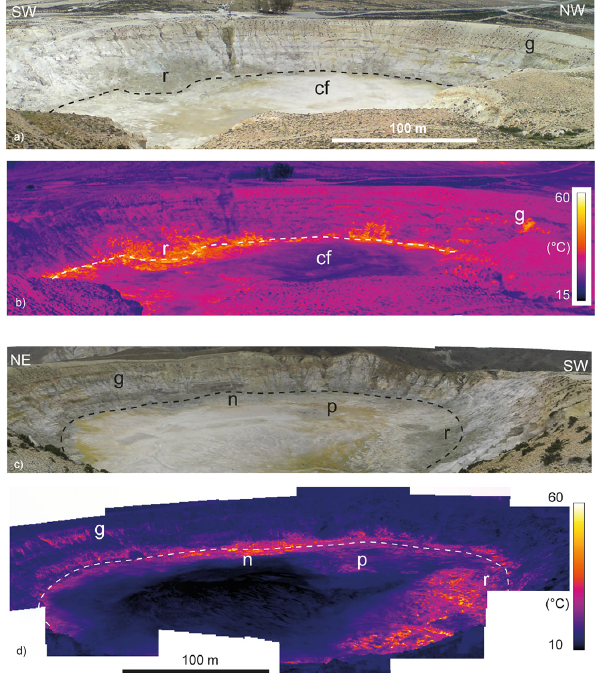
Fig. 3. (a, b) OP and IR daytime panorama viewing westward; the dashed line marks the crater’s bottom rim. (b) The thermal anomaly is visible at the break in slope of the flank and is wider in corre- spondence to the mound (r). The crater floor (cf) and the flank are generally cold; the lateral thermal gradient (from SW to NW) on the flank appears because of the insolation. The thermal anomaly along the flank (g) is volcanic and is stronger than the insolated areas. The insolation and the fine spatial resolution allow the IR data to display morphological features (e.g., horizontal layering, gullies). Temper- ature values are saturated at 15 and 60 ◦ C to optimize the view. (c, d) OP and IR nighttime panorama facing southeastward; the dashed line marks the crater bottom rim. (d) The thermal anomaly clearly shows its ring-shaped pattern at the break in slope of the flank; at the eastern (n) and western (r) sides the anomaly appears to be wider. Another anomaly (p) appears close to the center in the southern direction and represents the mud pits. Also visible is the thermal anomaly (g) along the flank, as observed in (Fig. a, b). Temperature values are saturated at 10 and 60 ◦ C to optimize the view. (a) and (c) also show the sites with high sulfur content